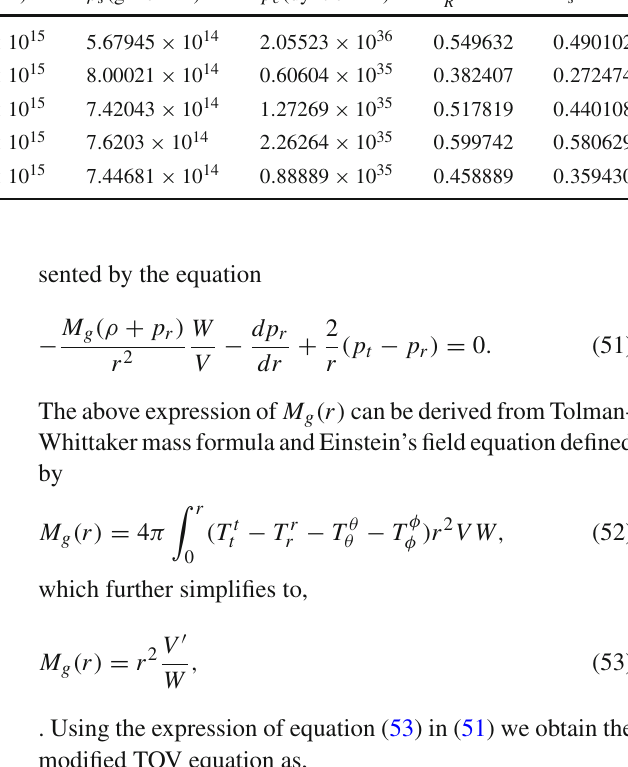
on adiabatic index depends upon the types of anisotropy. In